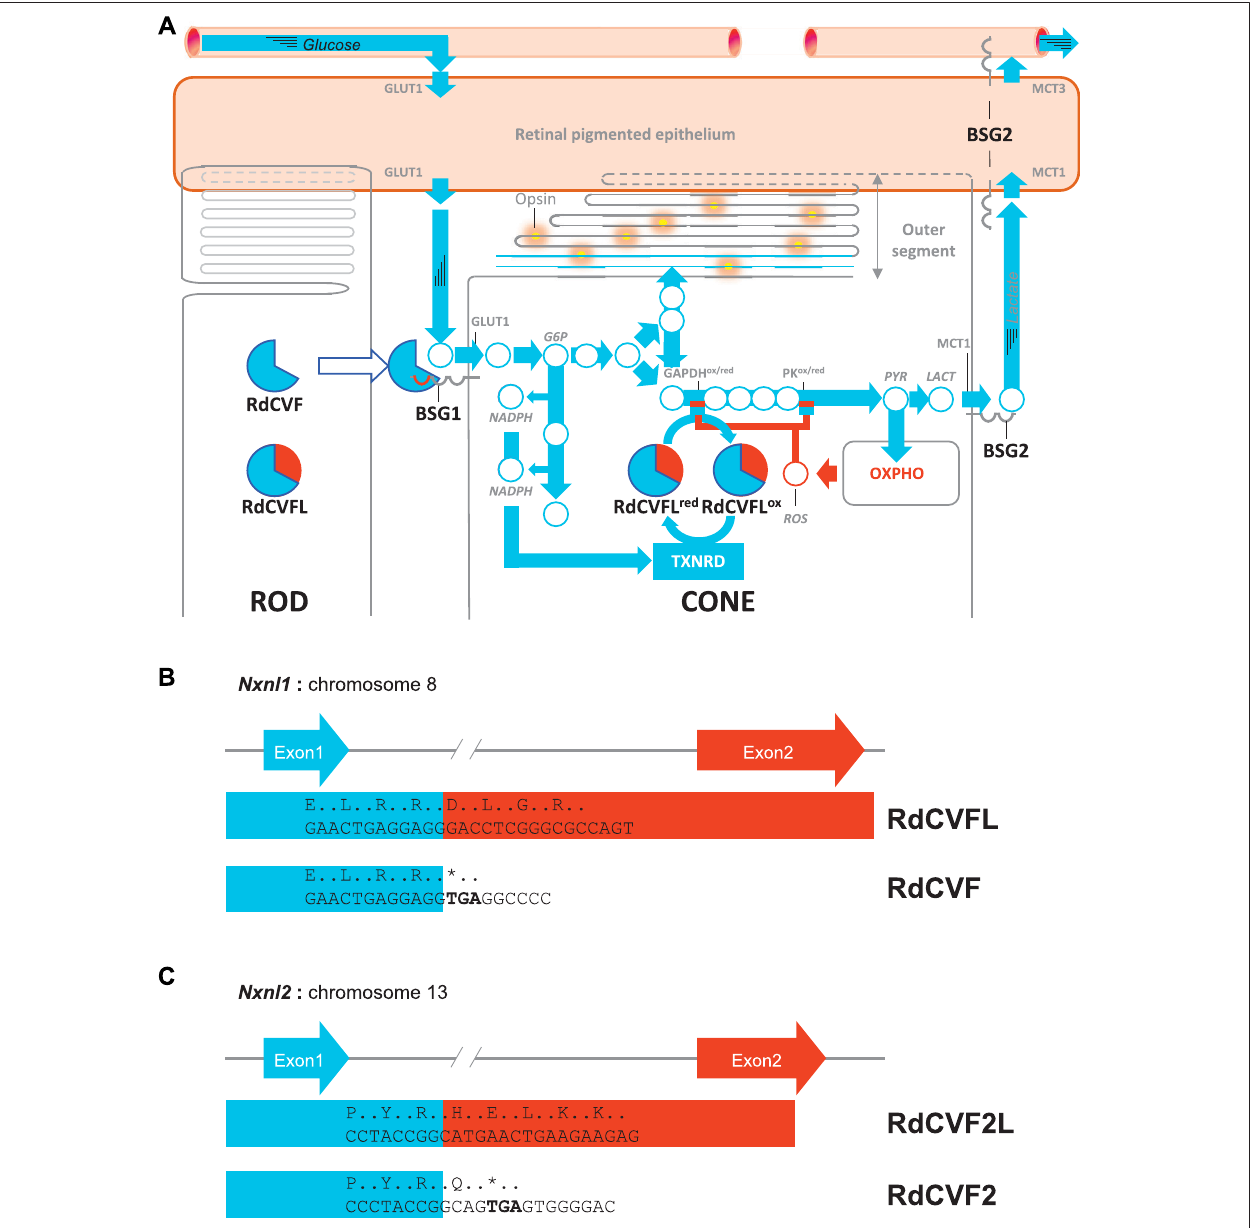
FIGURE1 | The metabolic and redox signaling ofthe nucleoredoxin-like genes. (A) The cellular interaction between rodsand conesin the retina. BSG1: basigin-1, BSG2, basigin-2, G6P: glucose-6-phosphate, GAPDH: glyceraldehyde-3-phosphate dehydrogenase, GLUT1: facilitated glucose transporter SLC2A1, LACT: lactate, MCT1: lactate transporter MCT1, MCT3: lactate transporter MCT3, NADP + : oxidized nicotinamide adenine dinucleotide phosphate, NADPH: reduced nicotinamide adenine dinucleotide phosphate, PK: pyruvate kinase, PYR: pyruvate, RdCVF: rod-derived cone viability factor, RdCVFL: rod-derived cone viability factor long, ROS: reactive oxygen species, TXNRD: thioredoxin reductase. (B) Schematic representation of the mouse nucleoredoxin-like 1 gene. (C) Schematic representation of the mouse nucleoredoxin-like 2 gene.